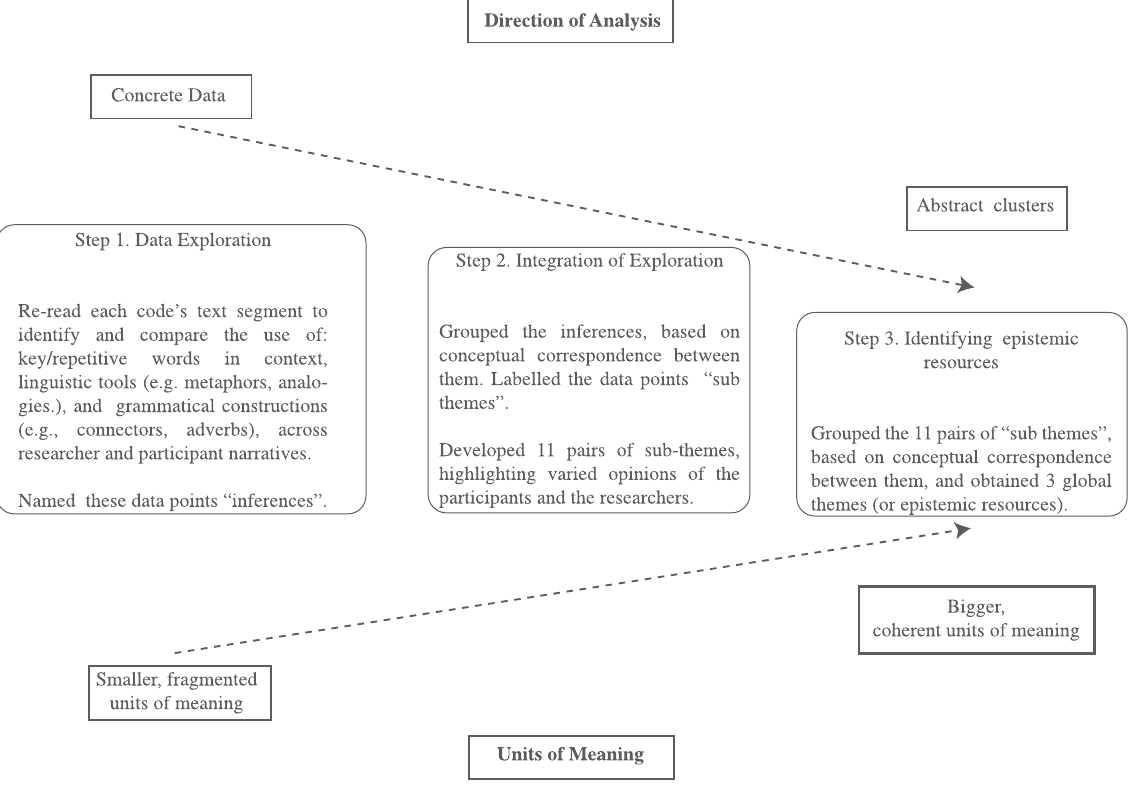
FIG. 10. Overview of coding procedures used to study connotative and interpretive variations in discussants ’ use of technical terms or